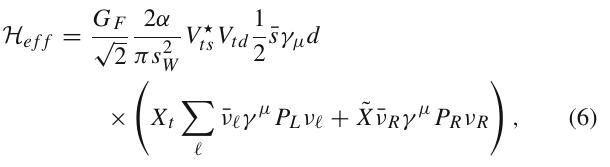
SM allowed region as predicted using the parameters